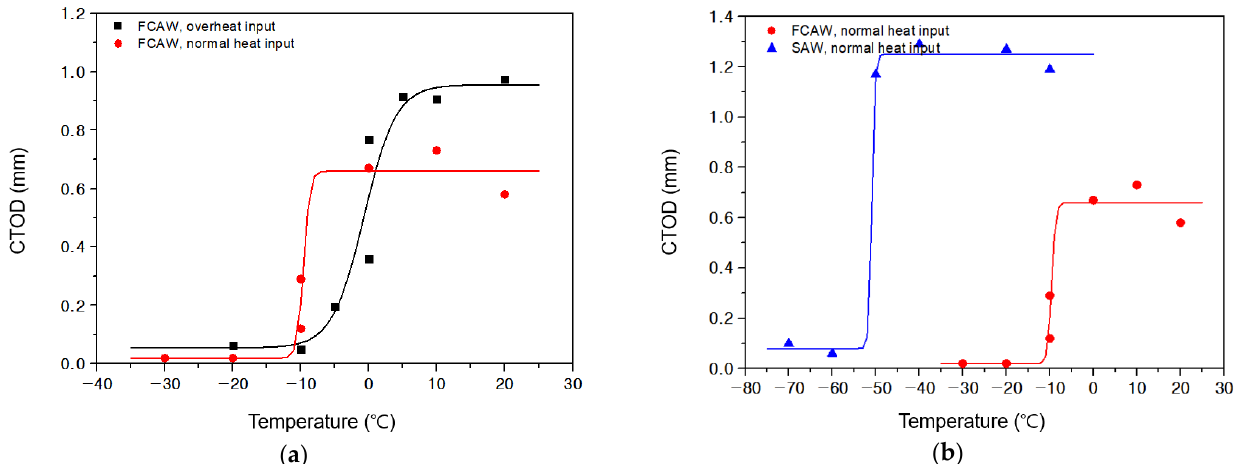
Figure 7. CTOD test results: ( a ) CTOD transition curve according to heat input; ( b ) CTOD transition curve according to welding method. Table 5. Hyperbolic tangent curve fit coefficient of CTOD test